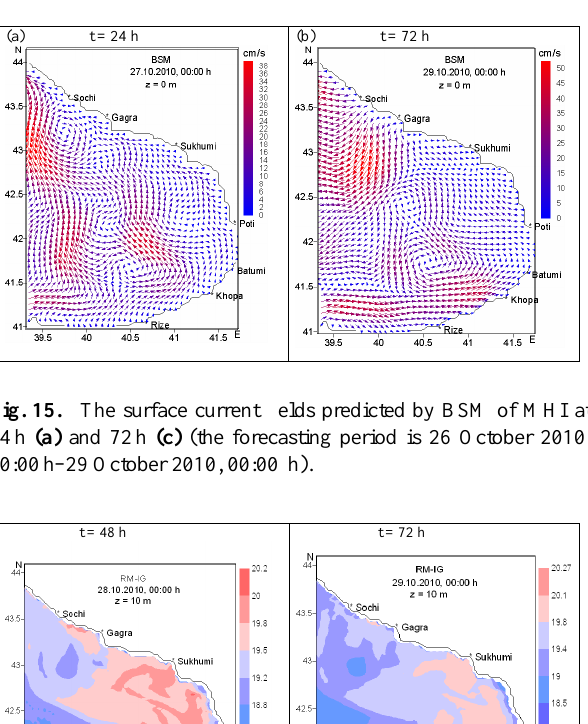
Fig. 16. The temperature fields (deg. C) on depth of 10 m predicted by RM-IG at 48 h (a) and 72 h (b) (forecasting period is 26.10.2010, 00:00 h – 29.10.2010, 00:00 h).